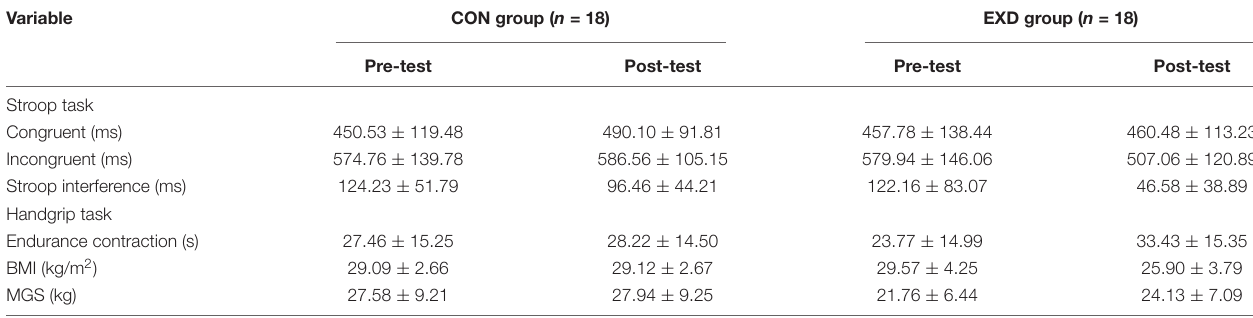
TABLE 3 | Group differences across time for Stroop task, handgrip task, BMI, and MGS (mean ± SD).